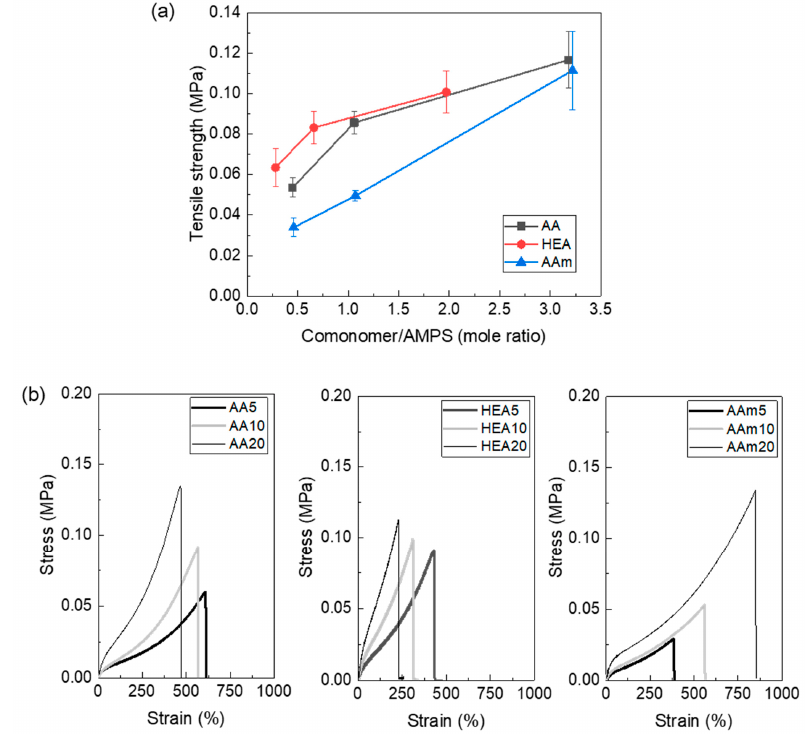
Figure 5. Tensile strength ( a ) and stress–strain curves ( b ) of AMPS hydrogels modified with different comonomers.